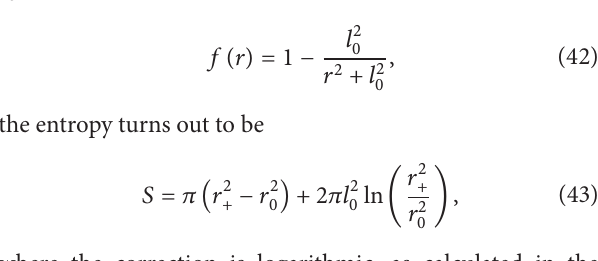
Figure15:Sketchesof 𝑓 󸀠 (𝑟) (blue), ℎ 󸀠 1 (𝑟) = 𝜆 1 (3𝑟 2 +𝛽 1 𝑟+𝑏 2 ) exp ((𝛽 1 /𝑏) tan −1 (𝑟/𝑏)) (green),and ℎ 󸀠 2 (𝑟) = 𝜆 2 (3𝑟 2 +𝛽 2 𝑟+𝑏 2 ) exp ((𝛽 2 /𝑏) tan −1 (𝑟/𝑏)) ̃ℎ 󸀠 (𝑟) = ̃𝜆(3𝑟 2 + ̃𝛽𝑟 + 𝑏 2 ) (red). The dashed brown (a) and dashed black (b) curves represent ̃𝛽 < 𝛽 ̃𝛽 < 𝛽 < 𝛽 𝜆 < ̃𝜆 < 𝜆 < 𝛽 𝜆 < 𝜆 < ̃𝜆 ), parameters, ( 1 2 , 2 1 ) and ( 1 2 , 2 1